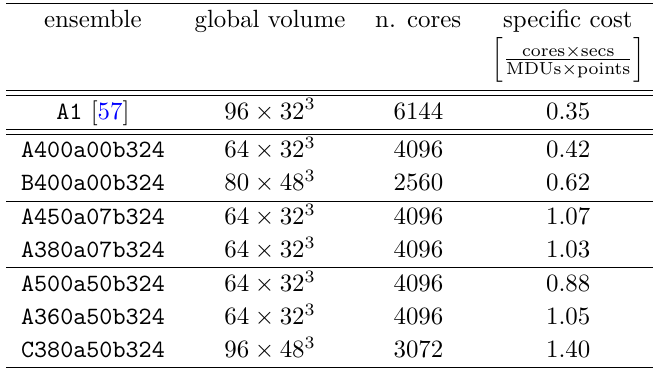
Table 12 . Cost comparison of all production runs presented in this paper, plus the N f = 3+1 QCD ensemble A1 produced by the ALPHA collaboration [57]. All wall times have been measured on Lise at HLRN. For each run we report the global lattice volume, the number of cores, and the specific cost i.e. the cost in coresecs per molecular dynamics unit (MDU) divided by the global volume. cost gap between the QCD+QED and QCD simulations, yielding